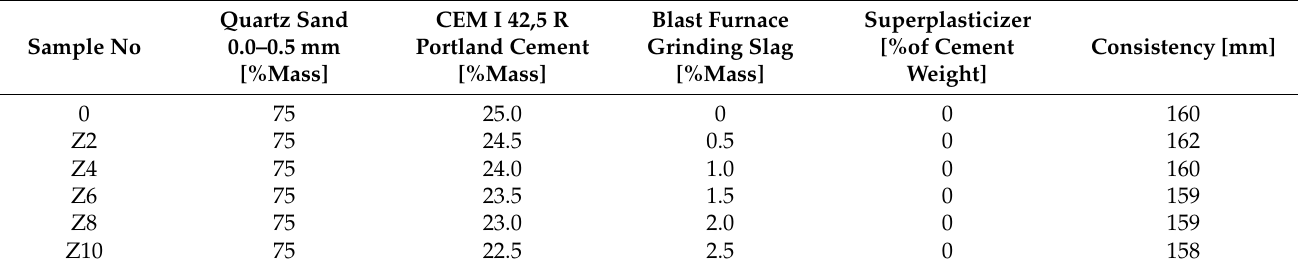
Table 7. Composition of samples modified with ground granulated blast furnace